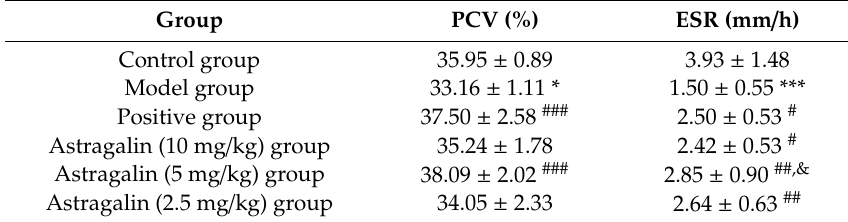
Table 9. Effects of astragalin on ESR and PCV (X ± SD, n = 8).